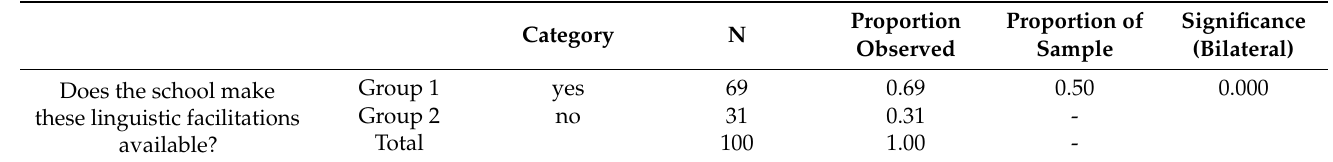
Table 3. Binomial test on the provision of facilitations.